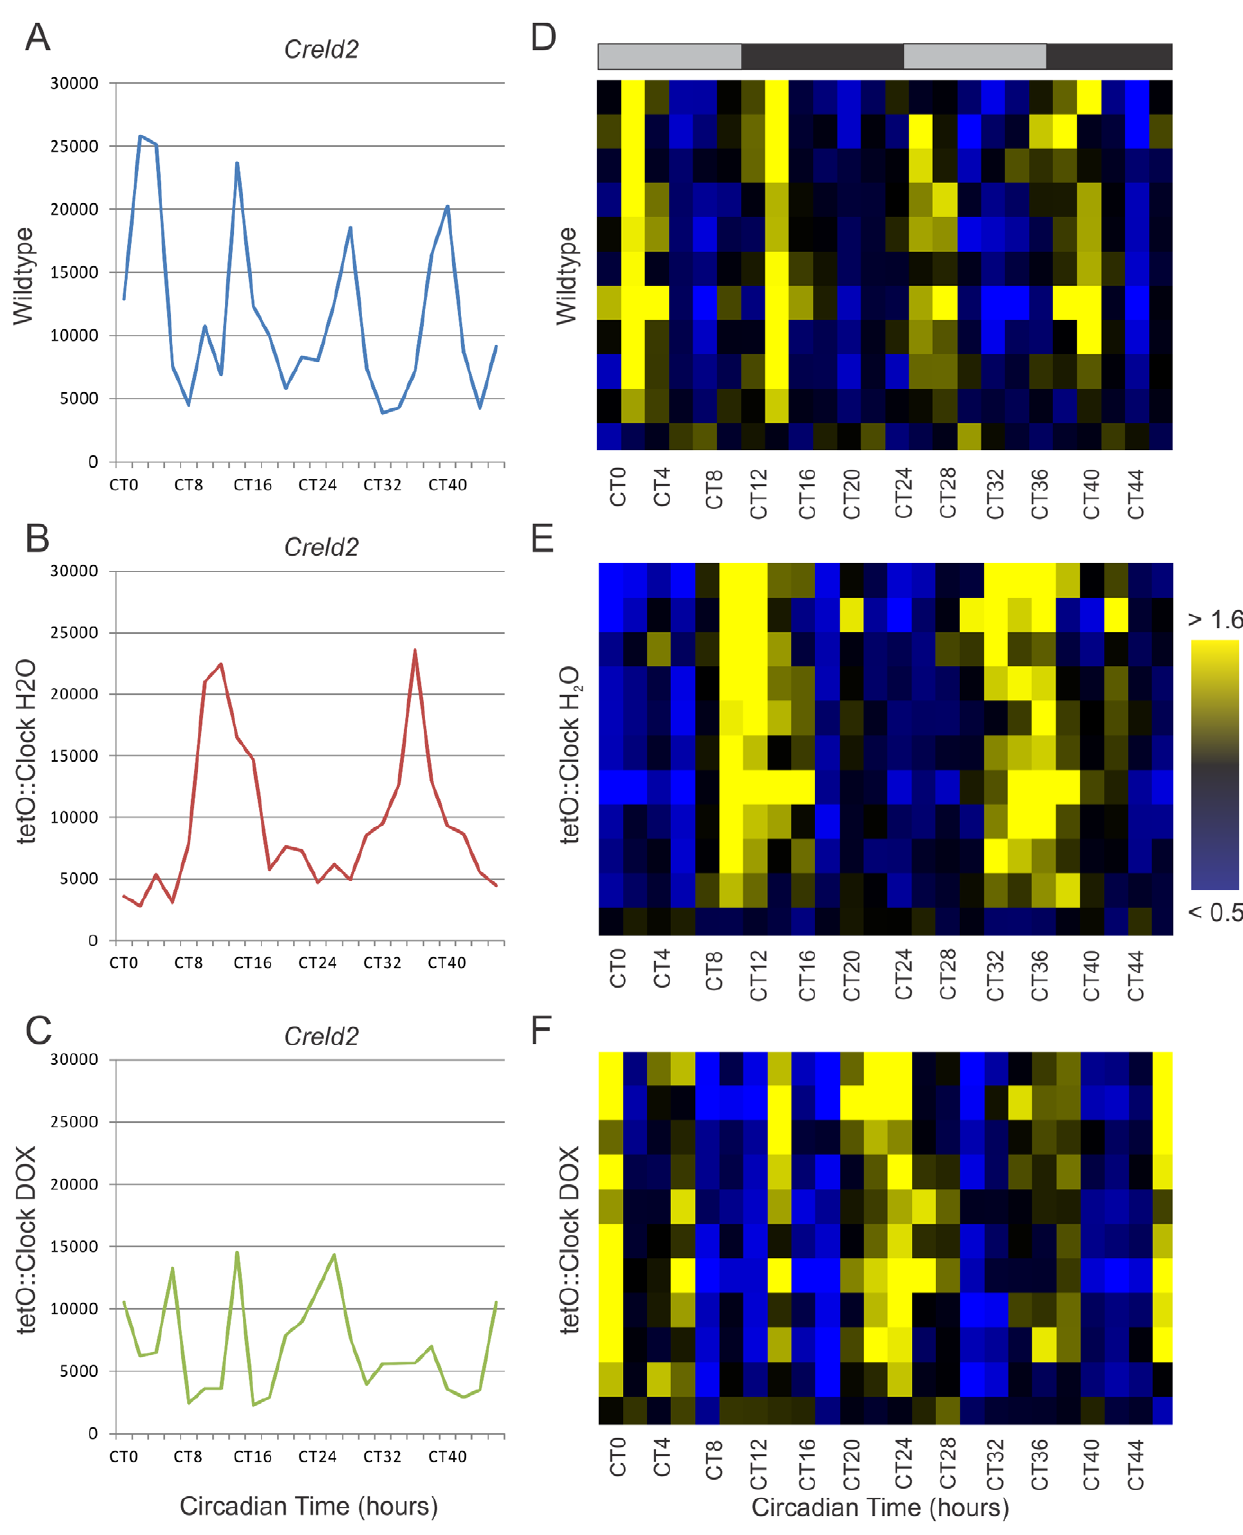
Figure 6. Clock -rescue restores 24- but not 12-hour rhythms to circadian harmonics. Panels A–C show the time course of Creld2 expression (a known 12-hour cycling gene) in wildtype (A), Clock -rescue (B) and Clock -mutant (C) livers. Panels D–F show a subset (N=11) of wildtype 12-hour rhythms median-normalized and plotted as a heatmap (yellow=high expression, blue=low expression). Every line represents the temporal expression of one wildtype 12-hour cycling gene. Shaded bars above the heatmaps represent subjective day and night.